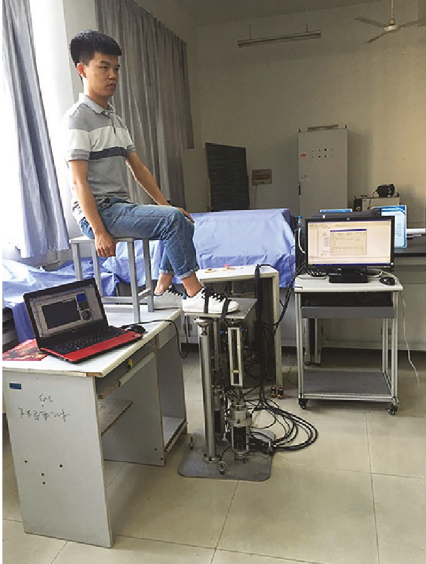
Figure 29: Testing the robot on a human ankle joint.